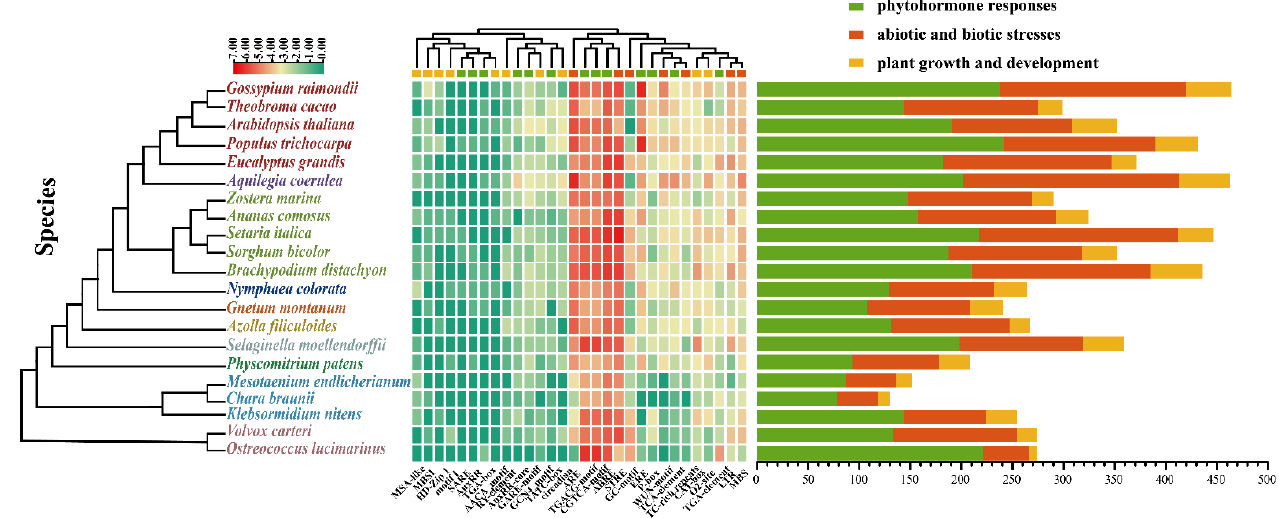
Figure 4. Analysis of promoter cis -elements of JmjC genes in plants. The left side of the heatmap is the evolutionary history of 21 species. Green, red, and yellow boxes represent cis -elements related to phytohormone responses, biotic and abiotic stresses, and plant growth and development, respectively. The histogram indicates the number of cis -acting elements of different types in each species.